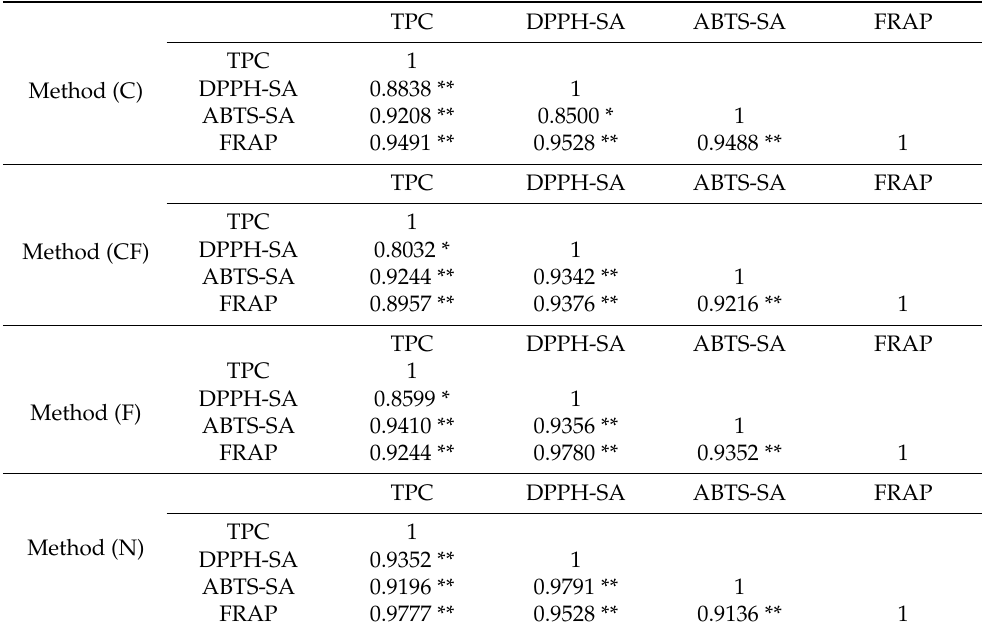
Table 3. Correlations of TPC, DPPH-SA, ABTS-SA and FRAP determined by different